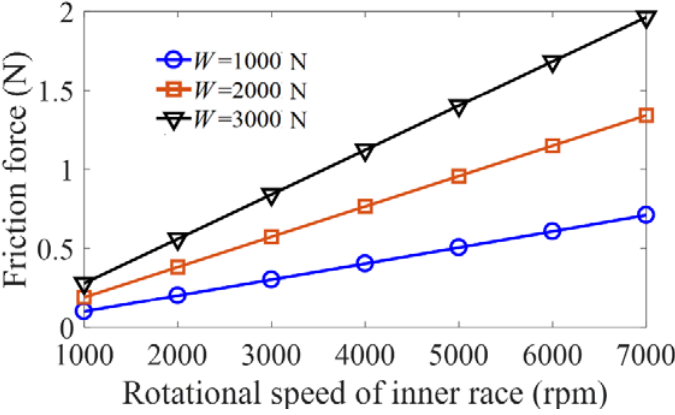
Figure 10. Effects of the rotational speed of inner raceway under different radial loads ( s c = 2%, μ m = 0.01).